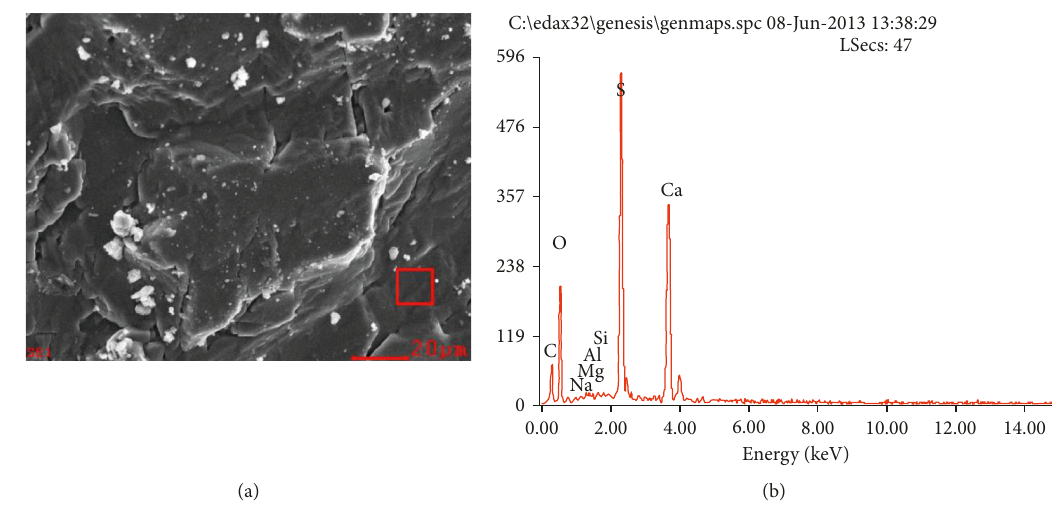
Figure 6: SEM and EDS images of the dense layer. (a) SEM; (b)